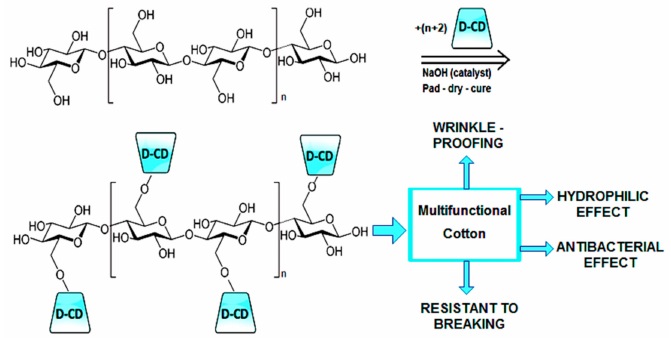
Figure 3. Getting multifunctional cotton (the chemical structures of D-CDs are shown in Scheme 1).